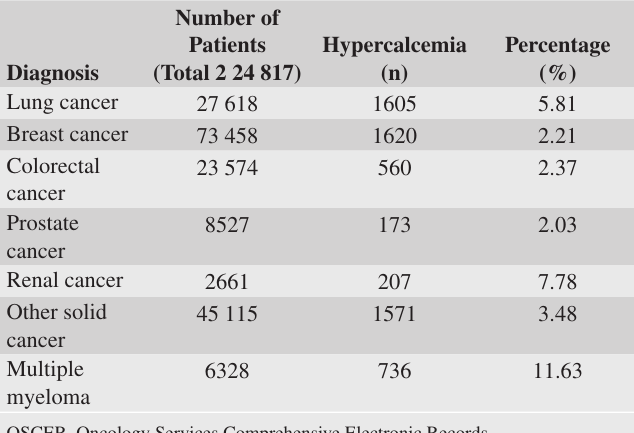
Table 1. Cancer Patients with Hypercalcemia in the OSCER